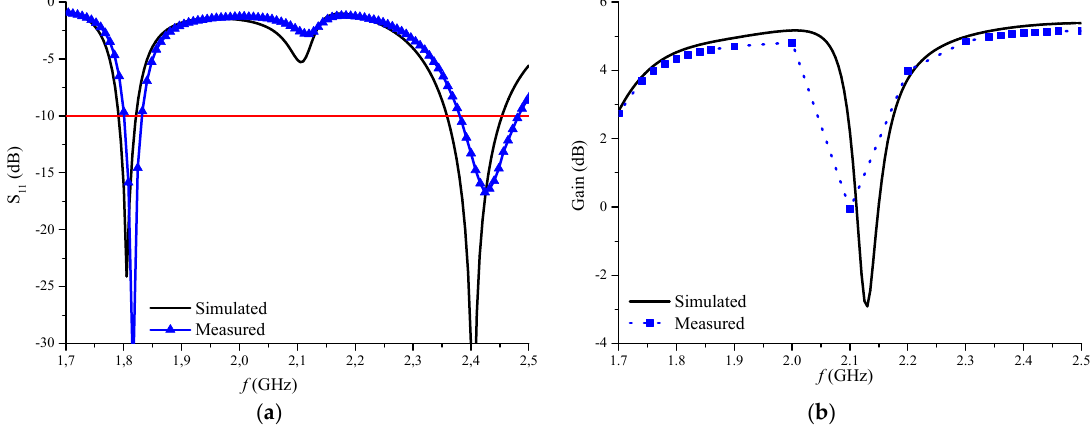
Figure 13. Comparison between simulated and measured results of: ( a ) S 11 and ( b ) gain of the proposed dual-band antenna.